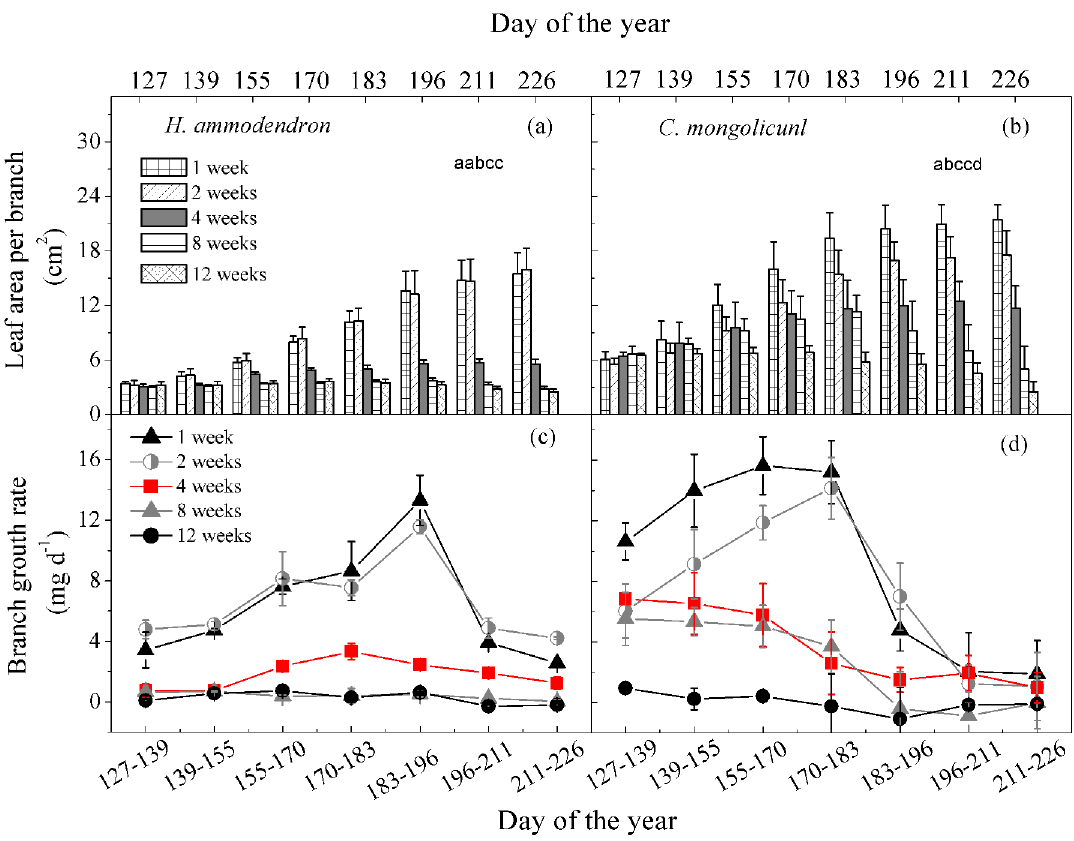
Fig 3. Seasonal changes in leaf area per branch and growth rate of branch biomass of H . ammodendron (a, c) and C . mongolicunl (b, d) for the five irrigation intervals. Error bars represent the standard deviationof the mean. Different lower-caseletters indicate significantdifferences amongtreatments ( P =